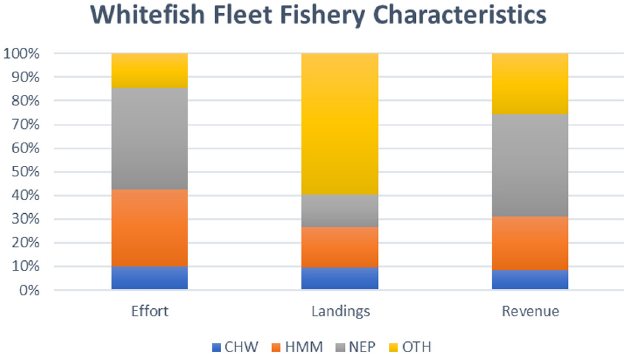
Fig. 3. Effort (days at sea), landings (tonnes) and revenue ( € ) shares of the white fi sh fl eet by fi shery (cod, haddock, whiting (cid:2) CHW; hake, monk fi sh, megrim (cid:2) HMM; nephrops (cid:2) NEP; all others (cid:2) OTH) in